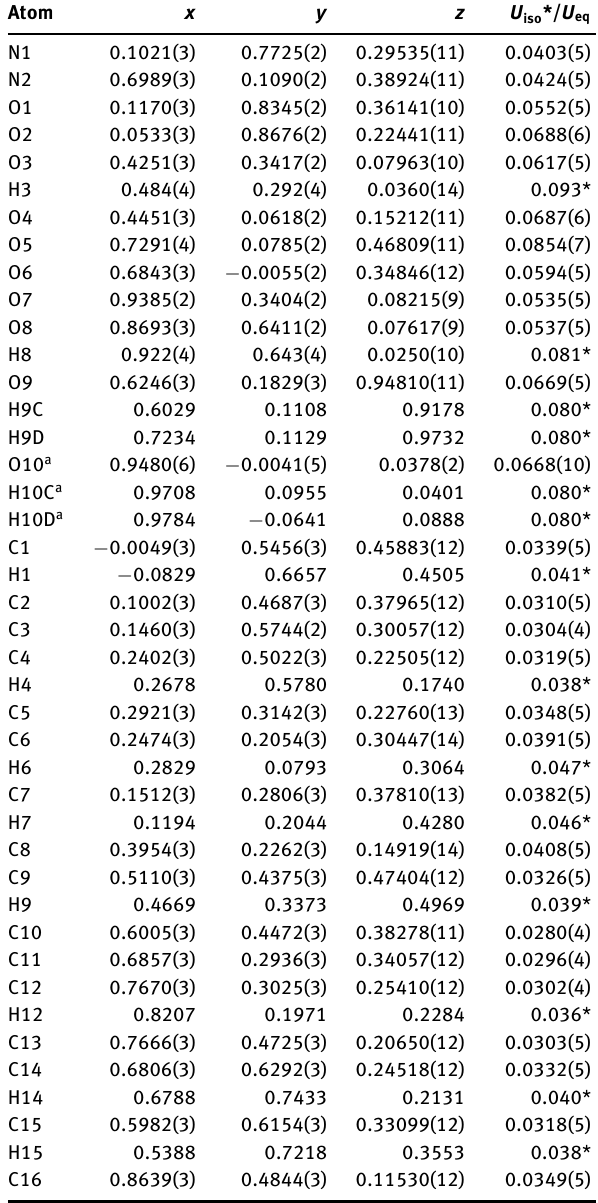
Table 2: Fractional atomic coordinates and isotropic or equivalent isotropic displacement parameters (Å 2